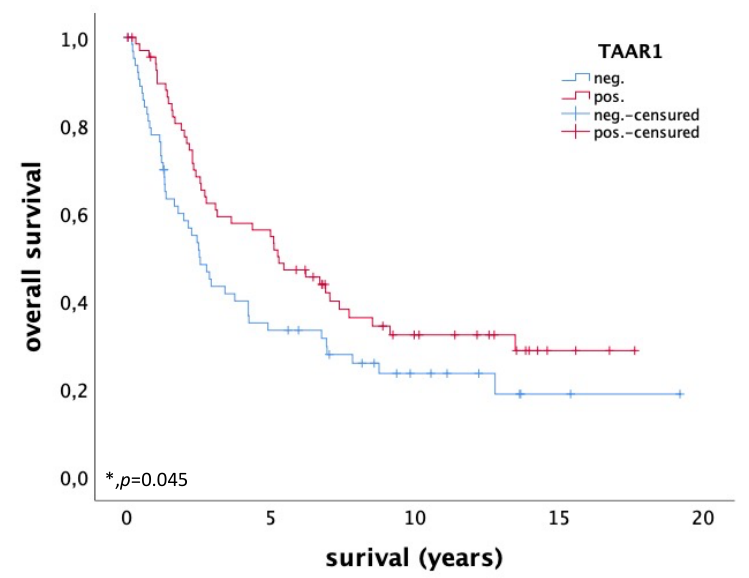
Figure 5. OS of patients with ovarian carcinoma with high ( n = 69) and low ( n = 64) TAAR1 expression. High TAAR1 expression is associated with a better OS in ovarian cancer patients ( p = 0.045); * p < 0.05 was considered statistically